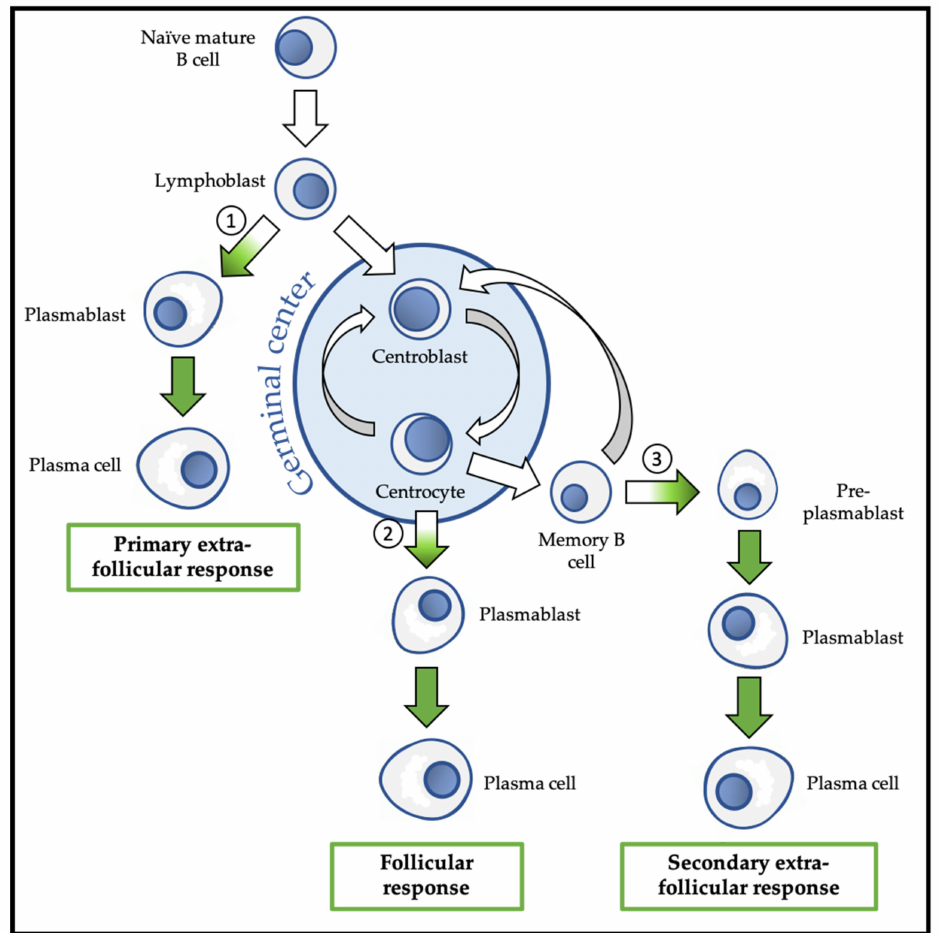
Figure 3. Overview of physiological di ff erentiation of plasma cells (PC). Upon primary antigen contact, naïve mature B cells are activated and become lymphoblasts that can choose between two pathways: the primary extra-follicular response and the primary follicular response. In the primary extra-follicular response, lymphoblasts immediately di ff erentiate into plasmablasts (PB) then into short-lived PC and produce immunoglobin M (IgM). In the primary follicular response, lymphoblasts enter a lymphoid follicle and form a germinal centre, while di ff erentiating into centroblasts and then centrocytes. During the germinal centre reaction, immunoglobulin class switch recombination (CSR) and somatic hypermutation (SHM) take place. After selection, the centrocytes di ff erentiate either into memory B cells, or into PB and then PC that produce IgG, IgA, or IgE. Upon secondary antigen contact, memory B cells are activated and can choose between a secondary extra-follicular response and a secondary follicular response. The secondary follicular response is similar to the primary follicular response and follows the same steps. In the secondary extra-follicular response, memory B cells immediately di ff erentiate into pre-plasmablasts (pre-PB), PB, and then PC. The numbers indicate the cell fate decision points, where the antibody-secreting cell (ASC) program is switched on. Green arrows indicate cell di ff erentiation steps where the ASC program takes